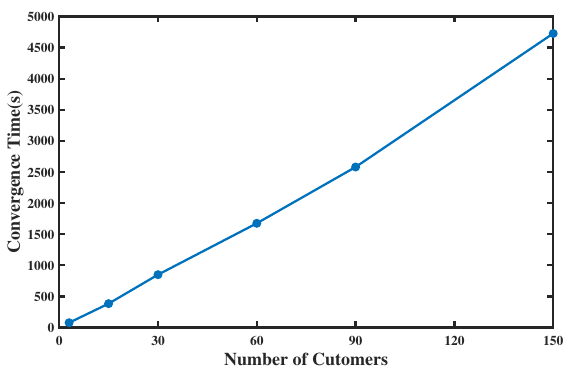
Figure 12. Convergence time of Algorithm 1 with different number of customers.